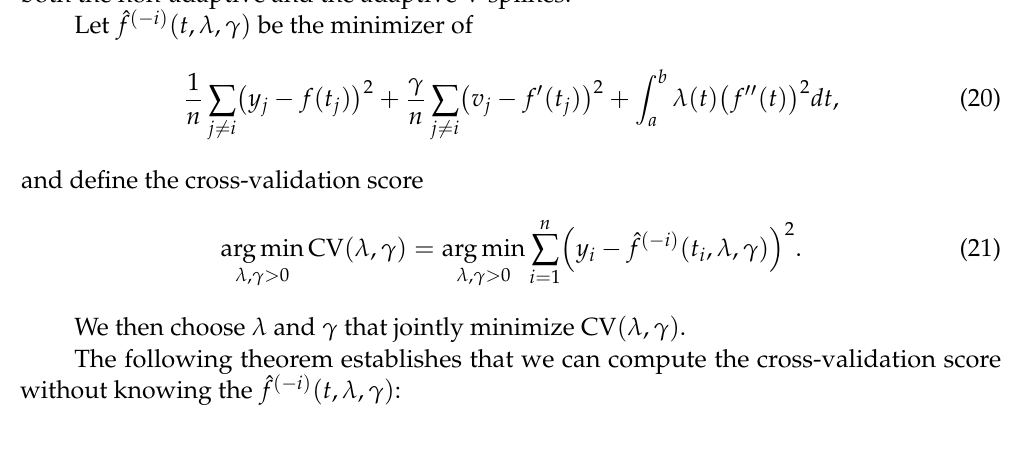
∆ T = y − y i i + 1 i is small, the adaptive V-spline favours straighter